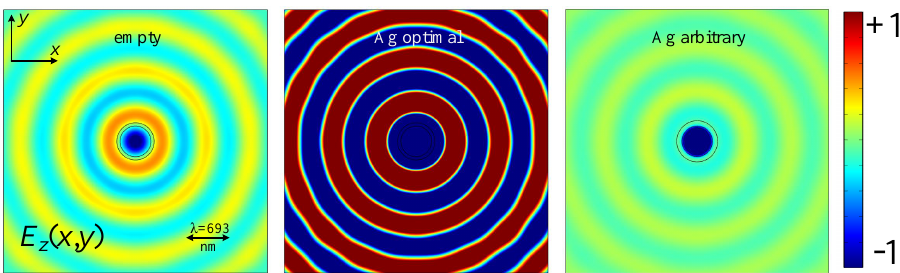
Figure 4. Spatial distribution of the normalized electric field E z ( z , y ) for: free space (left), optimal Ag cladding (center), and arbitrary, but close to optimal Ag cladding (right). The optimal design corresponds to the point of Figure 3a’s curve at λ = 693 nm. Design parameters: a / b = 0.82, b / λ = 0.42.